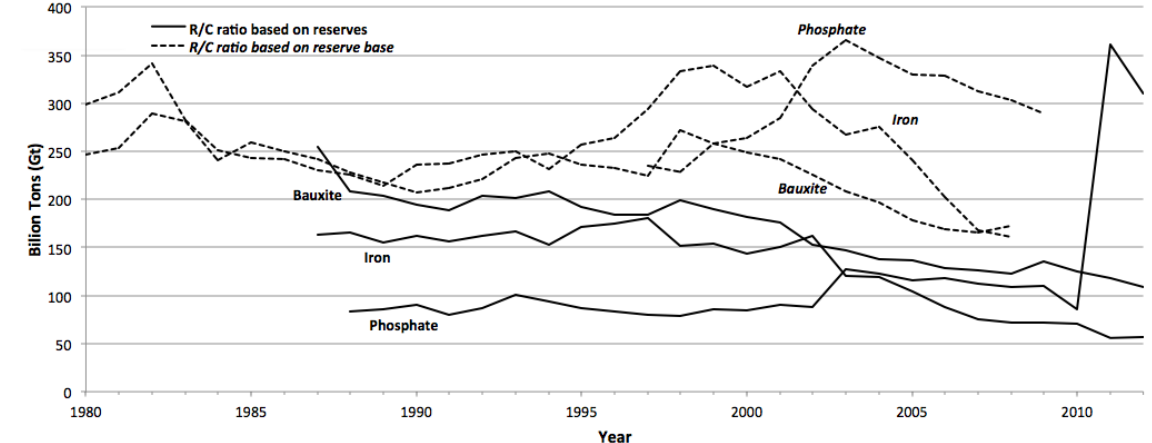
Figure 1. Comparison of the development of the R / C ratios (based on reserve base to 2008/09 and reserves) of phosphate with iron ore and bauxite (source: USGS MCS, BGR data